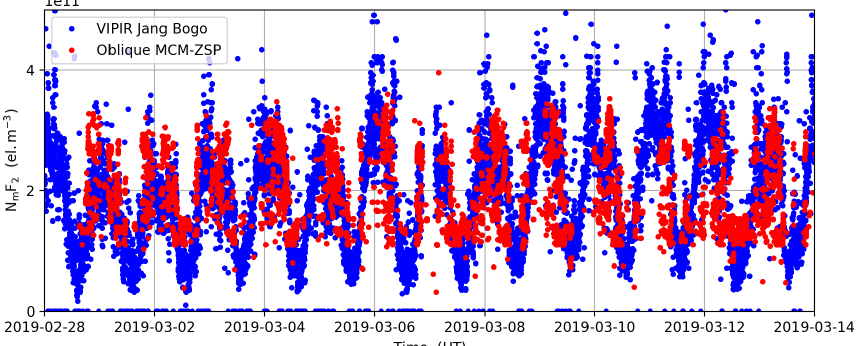
Figure 4. This figure shows NmF2 from the McMurdo–South Pole oblique experiment (red) and Jang Bogo VIPIR (blue). The two datasets are consistent, but the McMurdo–South Pole experiment shows a smaller range of values because it uses fewer